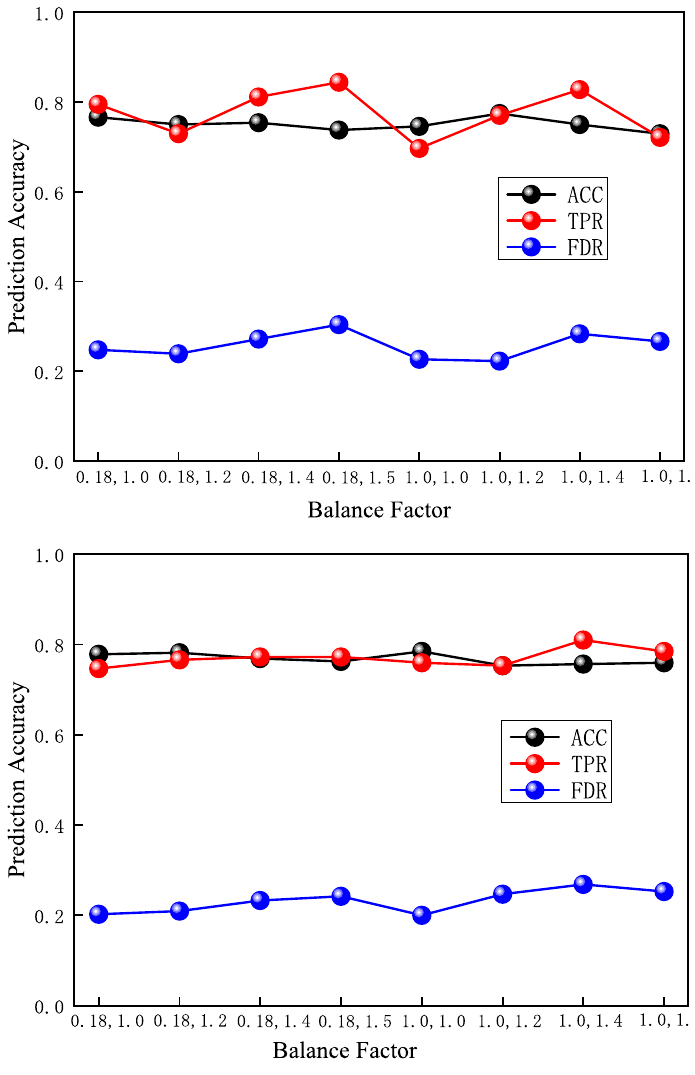
Figure 8. Test results of different balance factors.